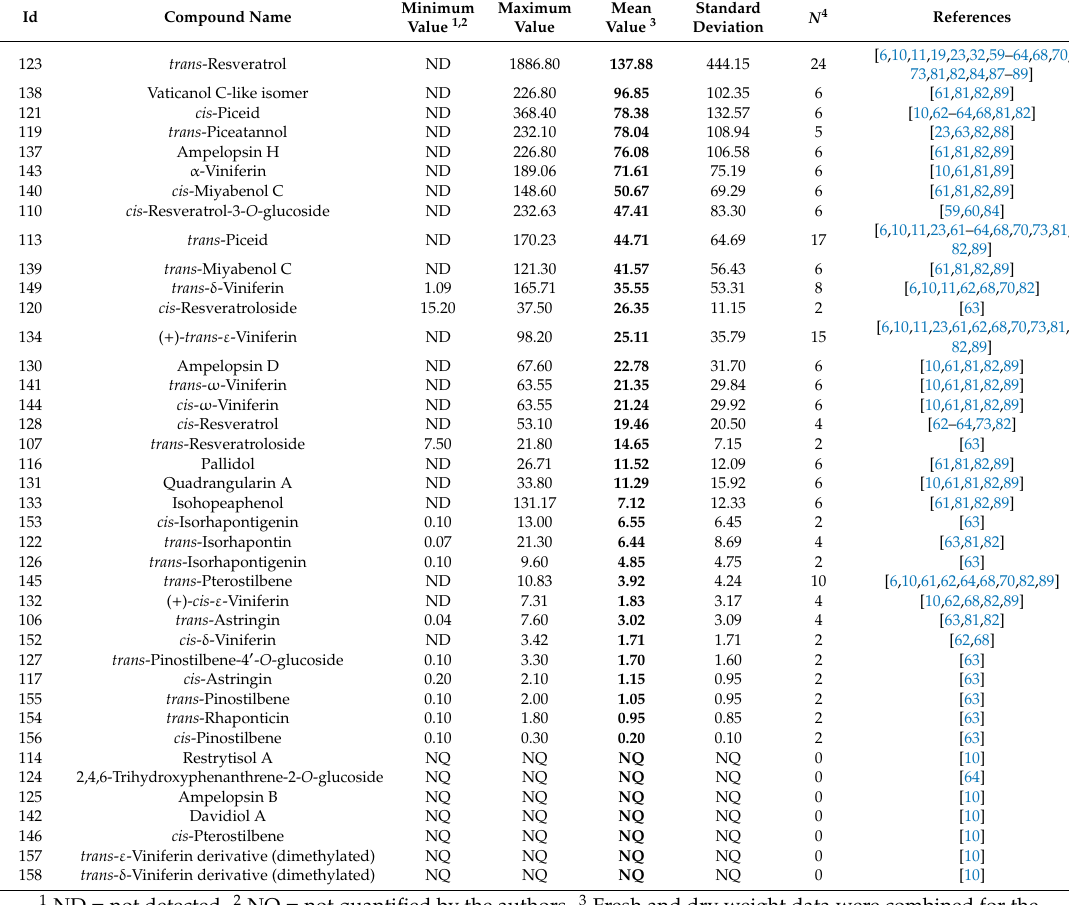
Table 4. Levels (mg / kg) of 40 stilbenic compounds identified in grapevine